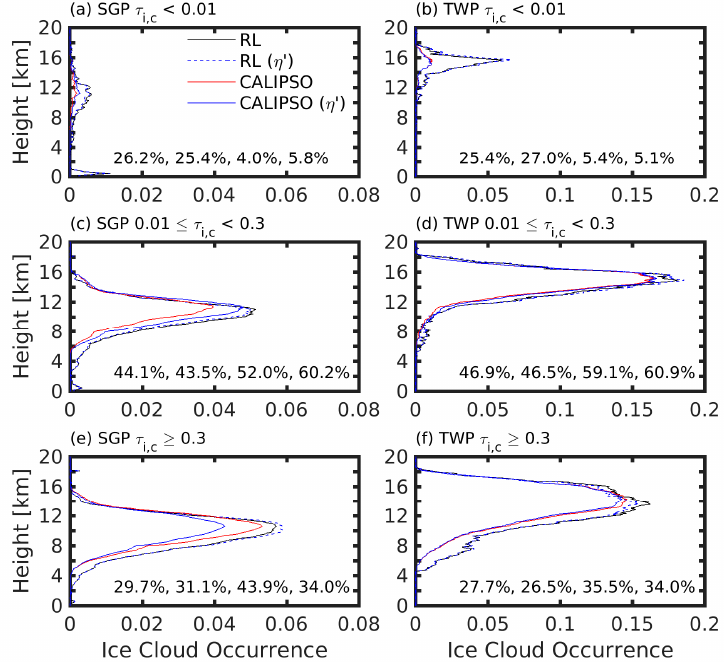
Figure 7. Ice cloud occurrence profiles from CALIPSO (solid red) and the RL with CALIPSO-like extinction resolution (i.e., 8 min/60 m at SGP and 24 min/60 m at TWP) using the best-estimate lidar ratio (solid black) for τ i , c < 0.01 (top), 0.01 ≤ τ i , c < 0.3 (middle), and τ i , c ≥ 0.3 (bottom) over SGP (left) and TWP (right). Also plotted are ice cloud occurrence profiles with lidar ratios determined by the CALIPSO’s Version 4 temperature-dependent effective lidar ratio parameterization divided by a constant multiple scattering factor of 0.8 for SGP and 0.7 for TWP for CALIPSO (blue) and the RL (dashed blue). Only considered are transparent collocated profiles by matching the percentage of transparent profiles from the RL and CALIPSO. Percentage of the distribution represented in each optical depth range are given for the RL, RL with matching lidar ratio between the RL and CALIPSO, CALIPSO and CALIPSO with matching lidar ratio between the RL and CALIPSO. Data are for times collocated between the RL and CALIPSO at the SGP site from August 2008 to August 2016 and the TWP site from December 2010 to January